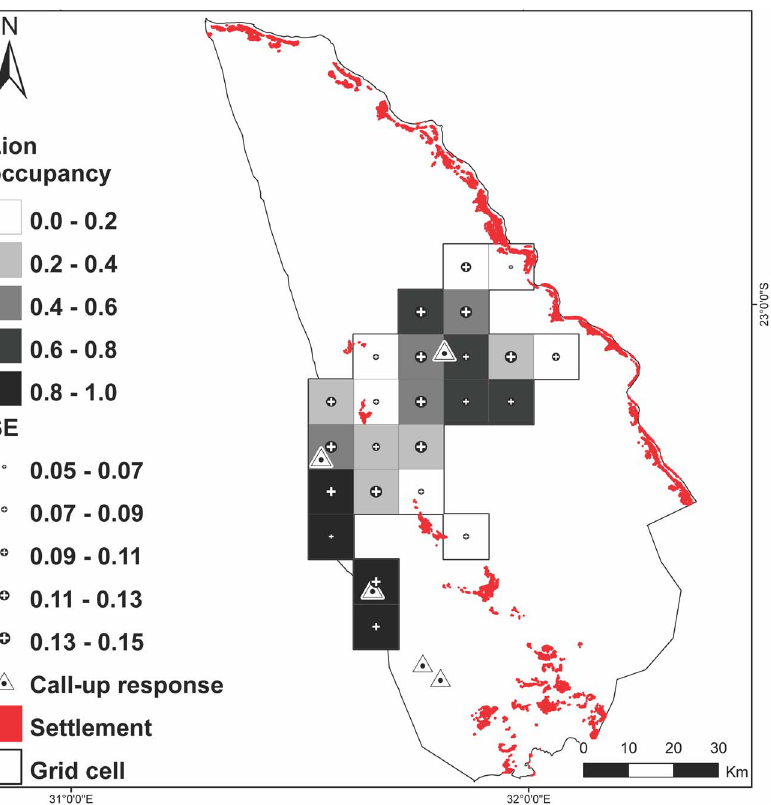
Figure 2. Spatial distribution of lion site occupancy and locations of call-up detections in the Limpopo National Park, Mozambique. Occupancy estimates are based on the averaged model ( g w . 0.95) from 206 (mean=9/grid cell) surveys of 24 (100 km 2 ) grid cells. Call-up detections are from a total of 43 stations.